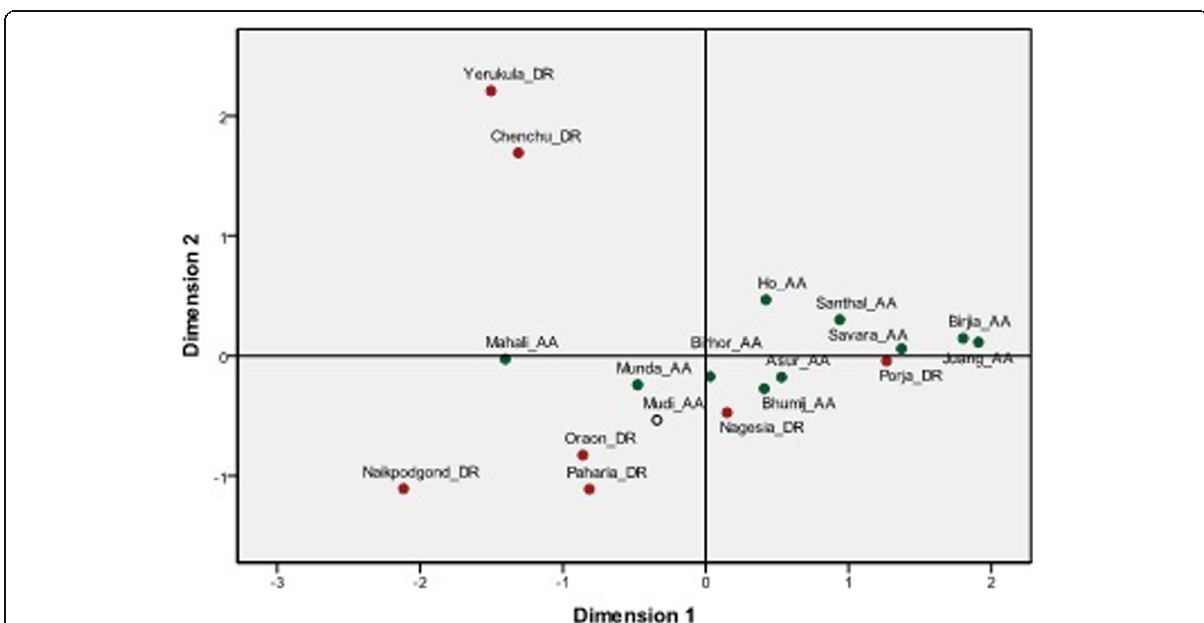
Fig. 3 Genetic relationships of populations based on Ø/ST distances estimated from Y chromosome haplogroup frequencies. AA Austro-Asiatic,